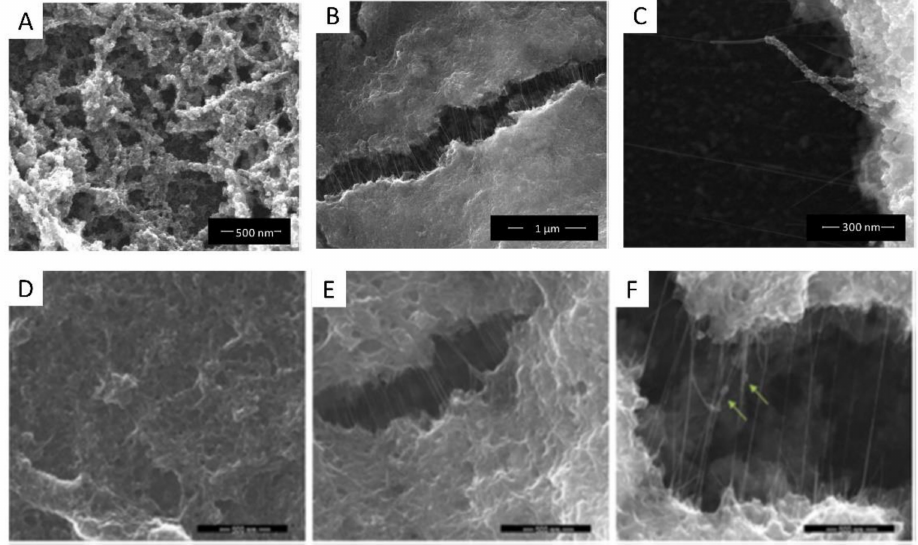
Figure 4. SEM images of IrO x -CNT (top A – C ) and IrO x -CNT-PEDOT hybrids (bottom D – F ) [18,27]. With permission from